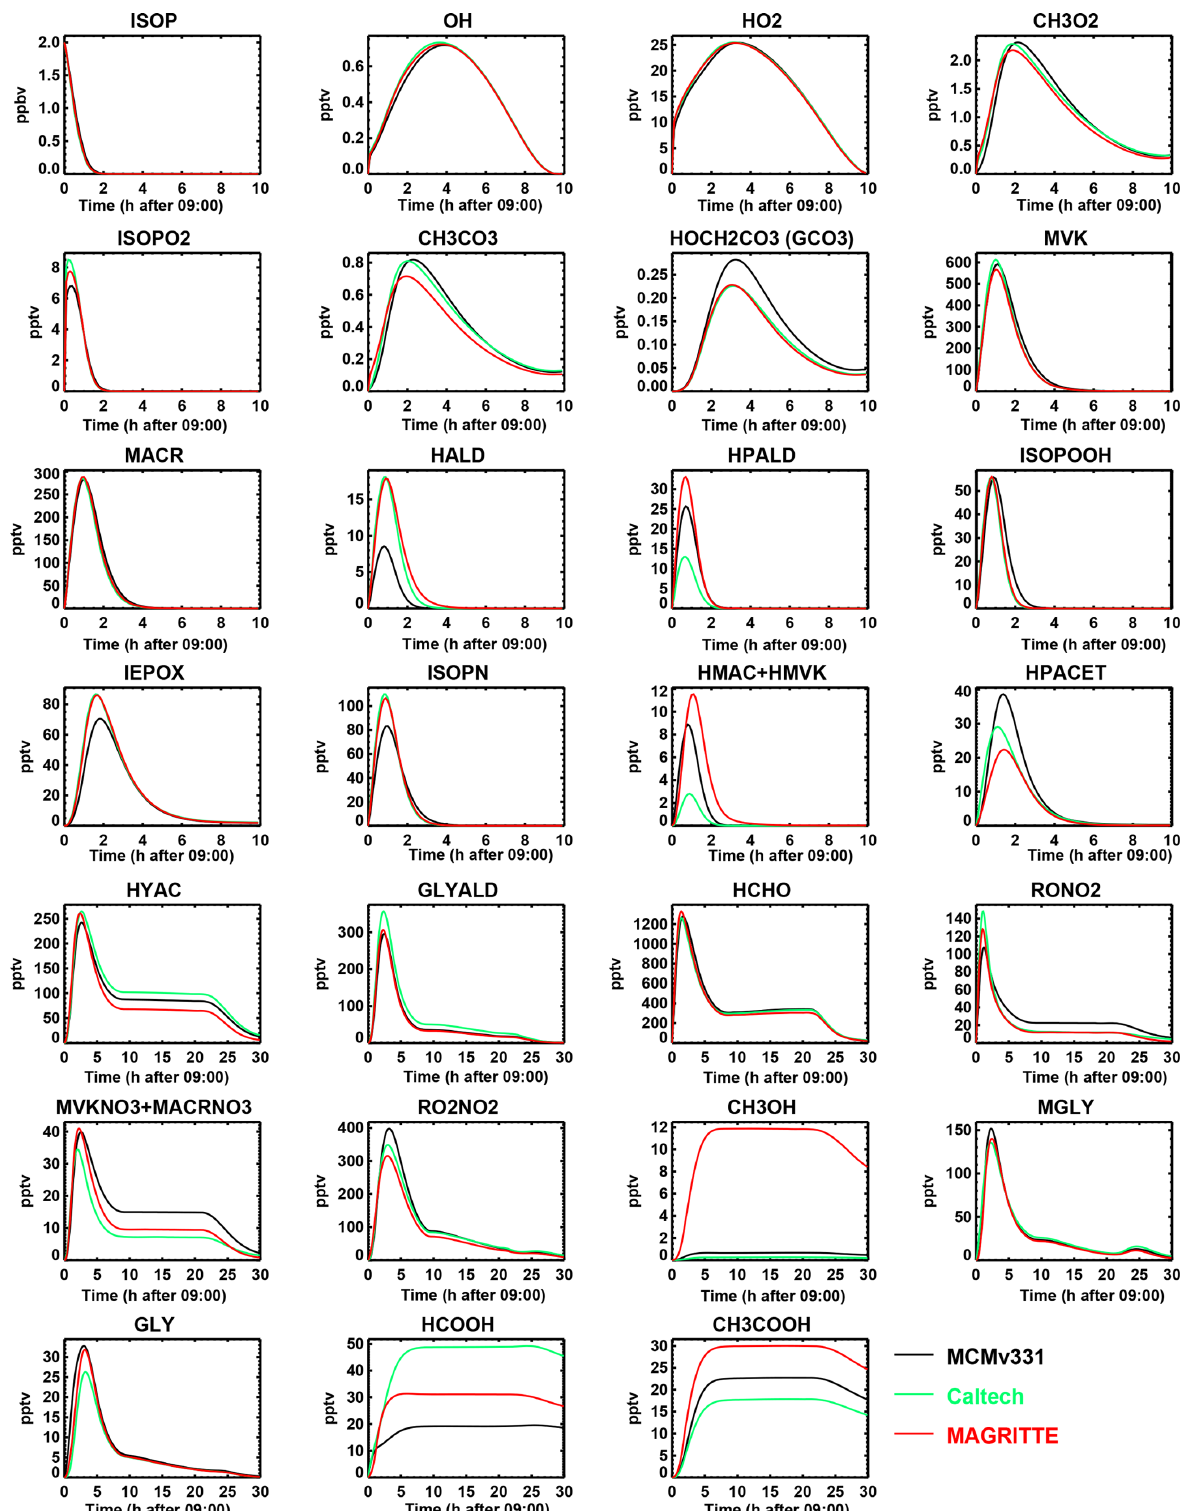
Figure 4. Box-model-calculated mixing ratios of key compounds at 1ppbv NO x . MCM results in black, Caltech mechanism in green, this work in red. ISOPN is the sum of isoprene hydroxynitrates; RONO2 is the sum of organic nitrates; RO2NO2 is the sum of